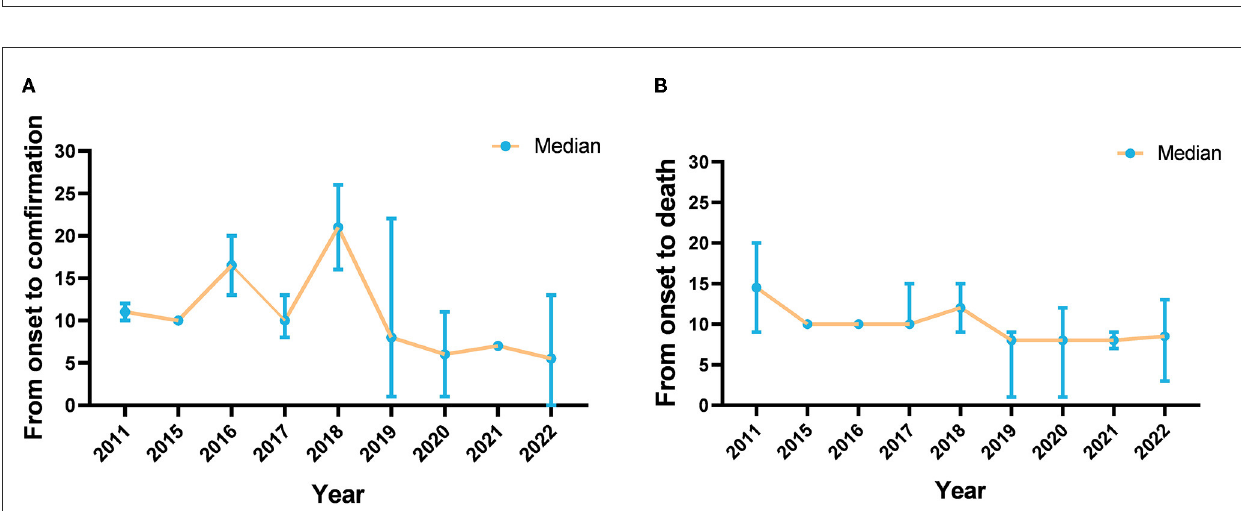
FIGURE4 The interval between illness onset, confirmation, and death of SFTS cases in Jiangsu province from 2011 to 2022. (A) Is the interval between illness onset and confirmation, and (B) is the interval between illness onset and death.